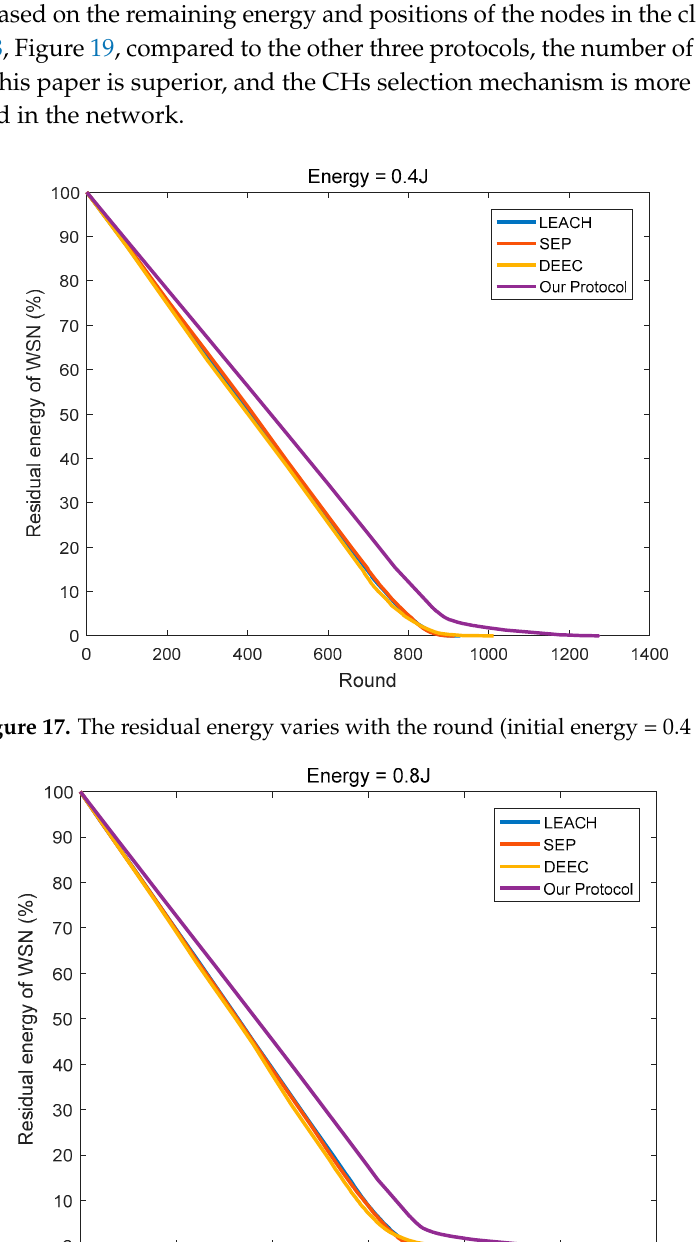
Figure 16. The number of surviving nodes varies with the round (the initial energy is evenly distributed at 0.4–0.8 J).